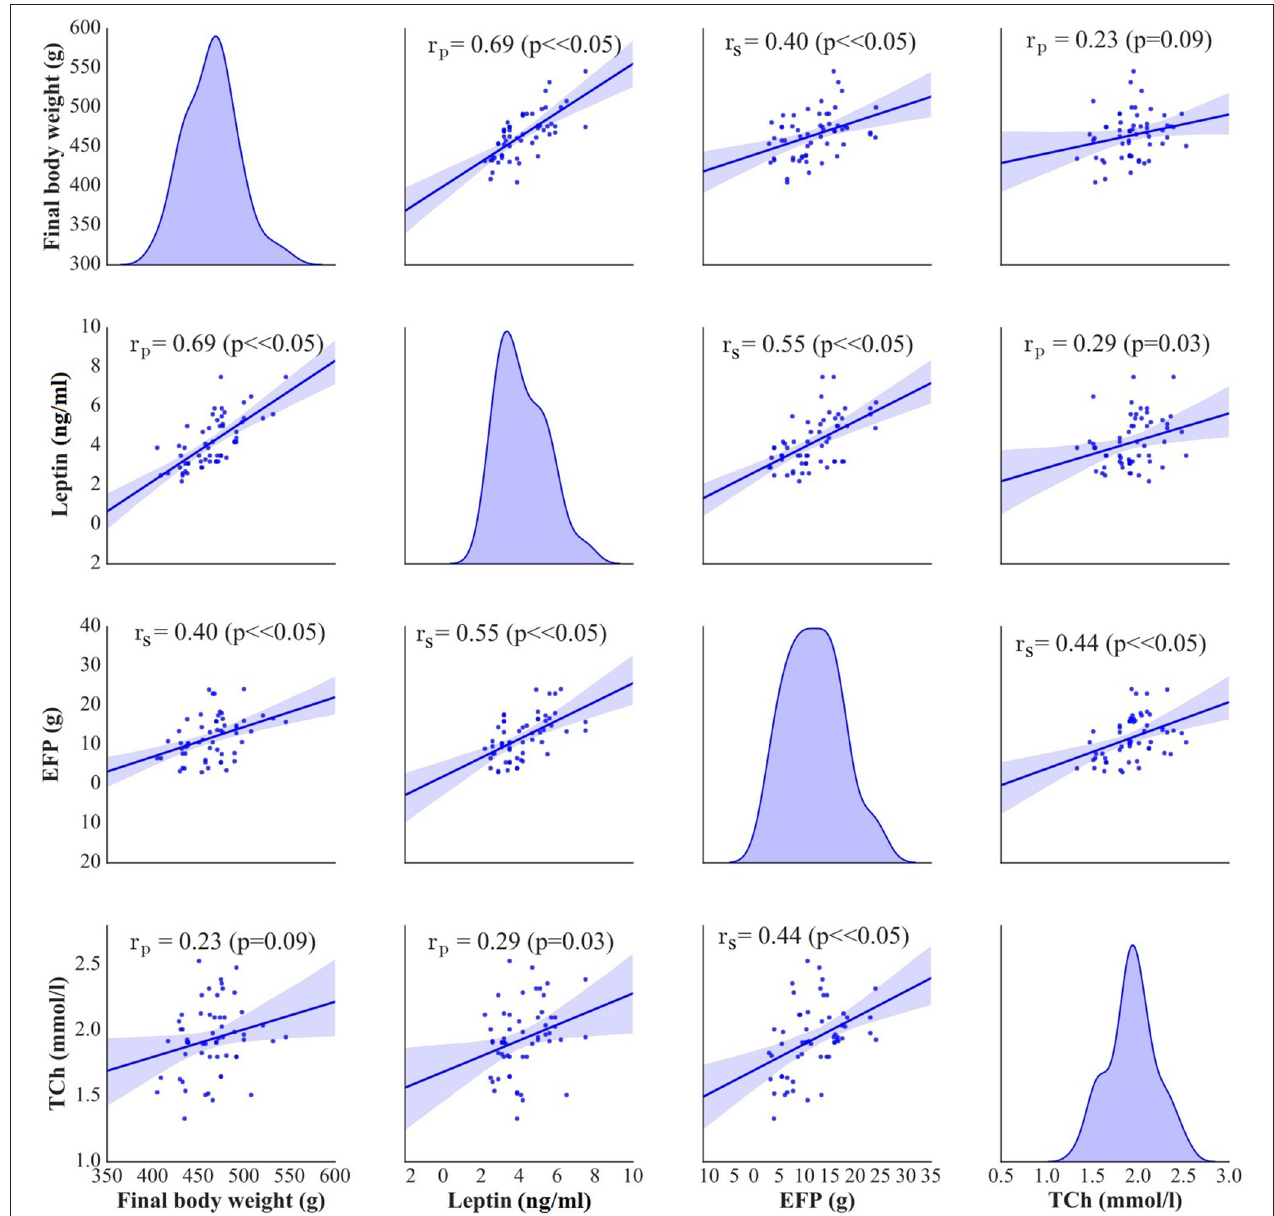
FIGURE 5 | Pearson’s or Spearman’s correlation between final body weight [g], serum leptin [ng/ml], epididymal fat-pads (EFP) [g], and total cholesterol levels (TCh) [mmol/L]. On the diagonal of the multiple pairwise bivariate distribution plot, the kernel density estimate of the probability density function is shown for each variable subjected to the correlation